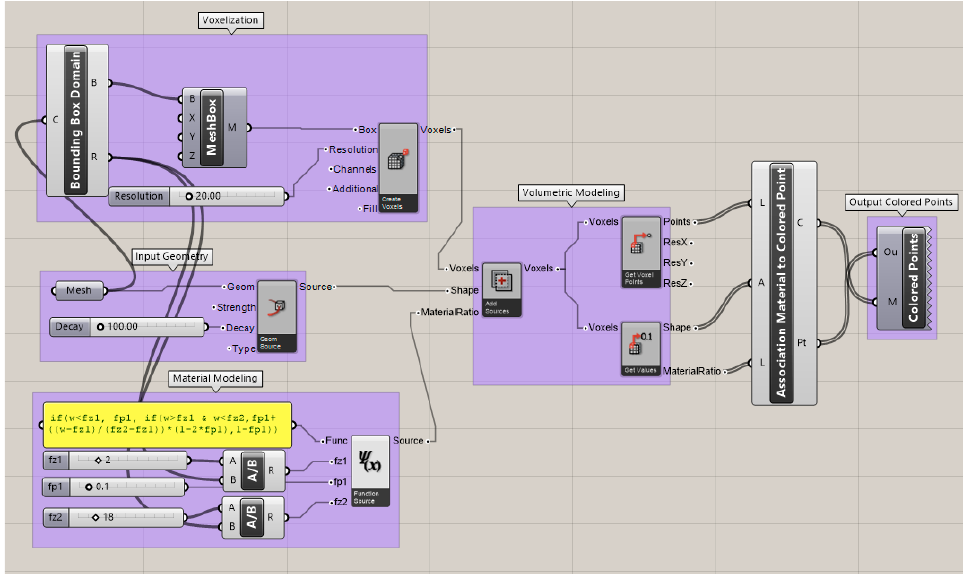
Figure 5. Grasshopper definition for the volumetric modeling.